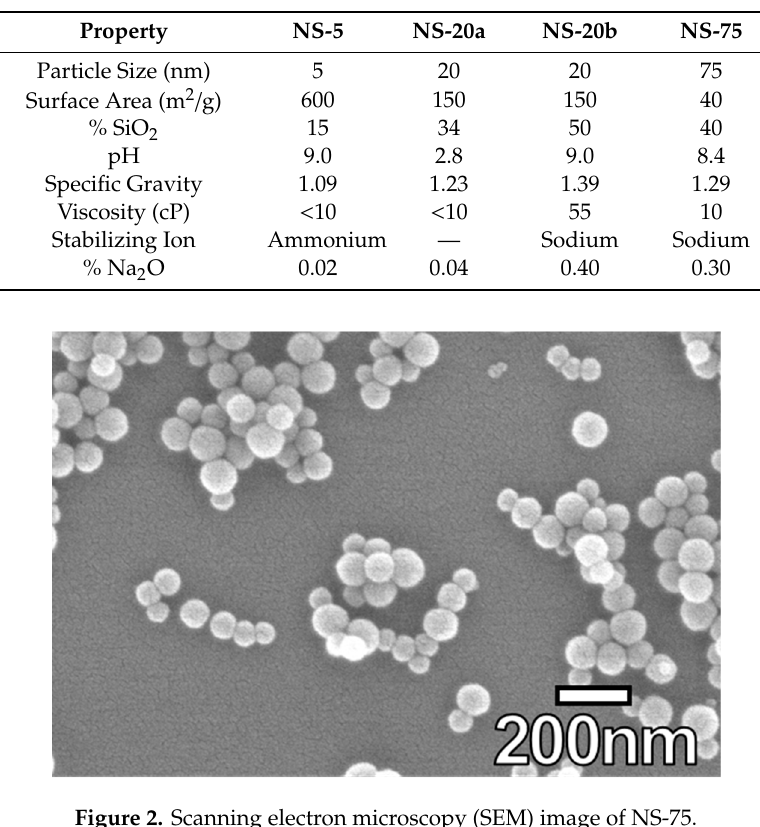
Table 1. Properties of NS sols.